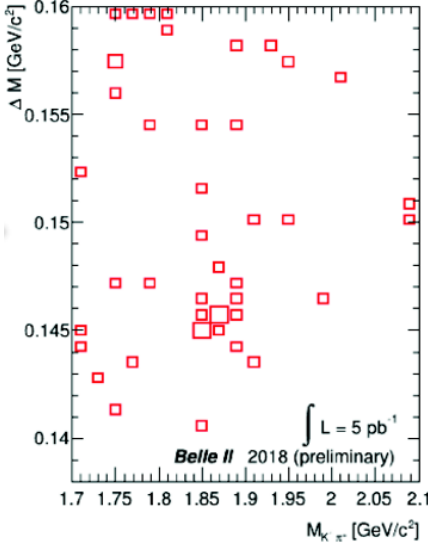
Figure 2. Preliminary plot of the invariant mass distribution of the K − π + system vs the mass di ff